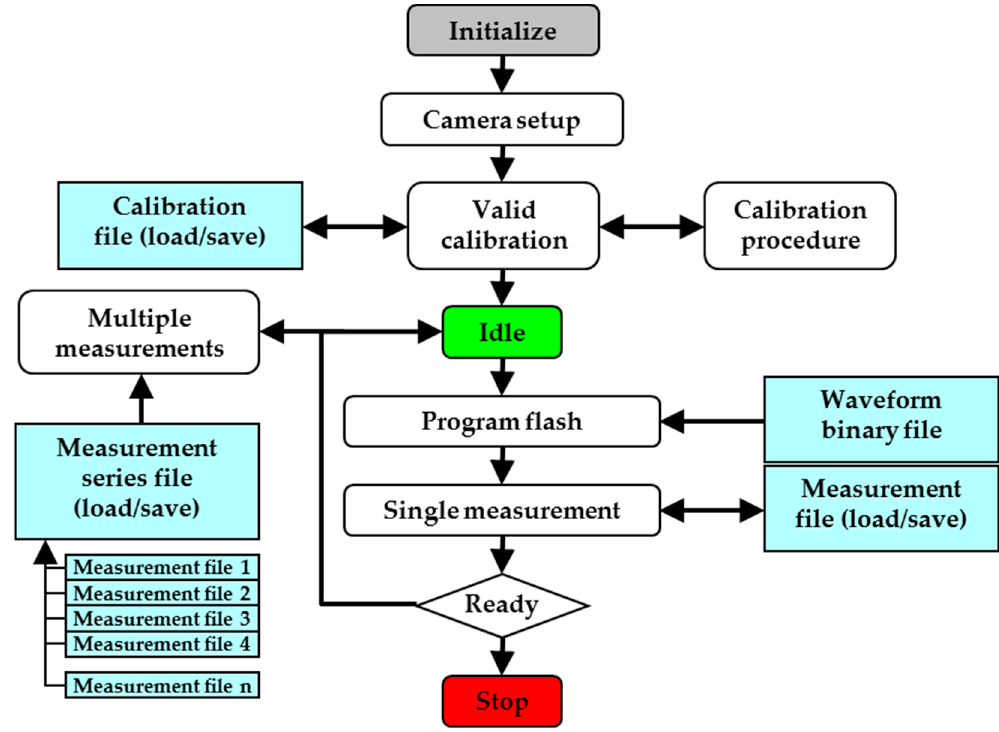
Figure 10. The flow chart of data acquisition. Calibration includes the effective number of measurement area blocks, the international white and black reference grayscale reflectance. The measurement mode includes single measurement and multiple measurement.